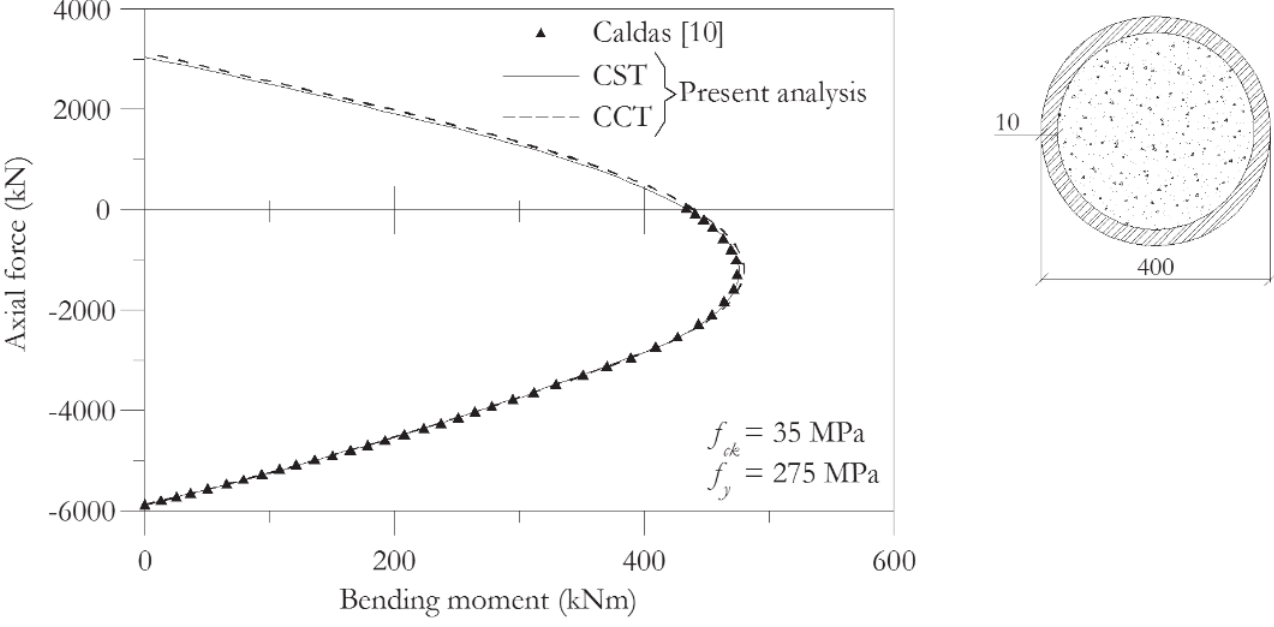
Full yield curve for circular composite